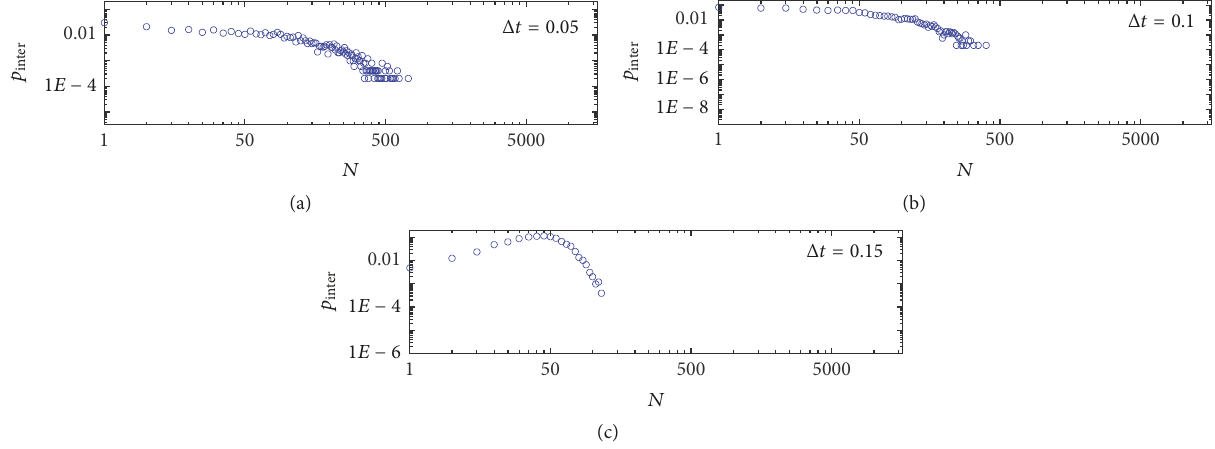
Figure 4: Histograms of cumulative group size in the consensus state for Δ𝑡 = 0.05, 0.1, 0.15, 𝜇 = 0.4 , and the 𝑥 -axis is 𝑁 𝑖 . The results are averaged on 10 5 iterations of the